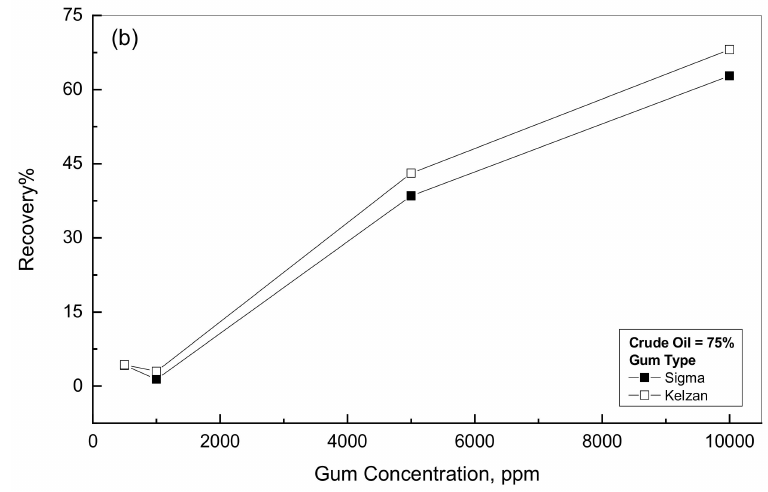
Figure 9. Recovery behavior for 25% and 75% crude oil-gum emulsions. ( a ) Low crude oil concentra- tion; ( b ) High crude oil concentration. Table 2. Creep modelling using Maxwell equation for lower gum